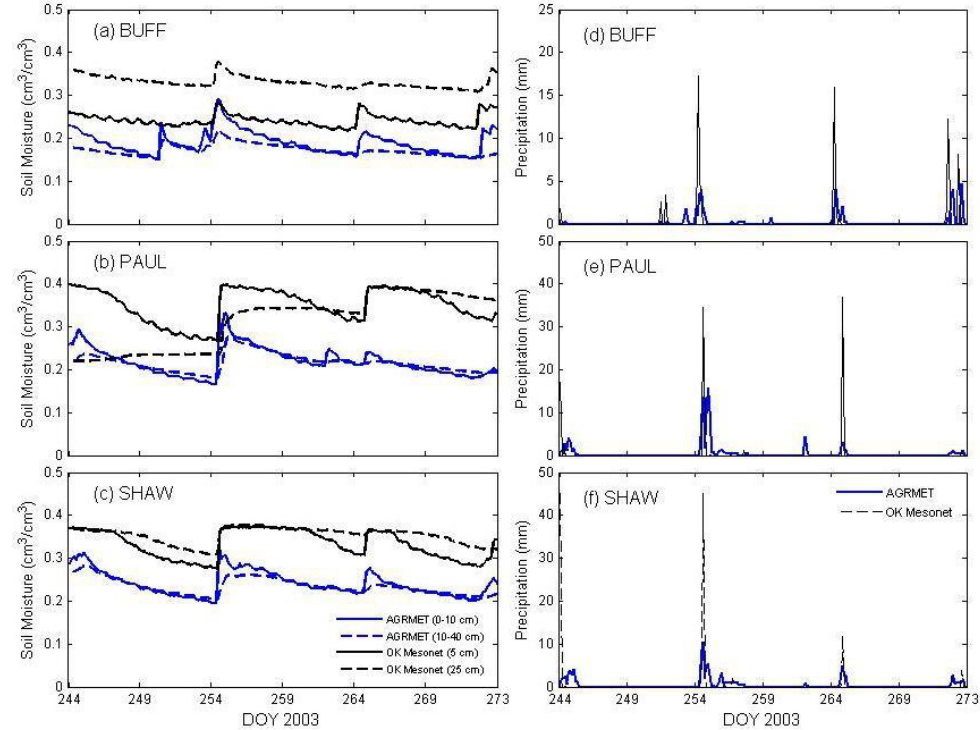
Figure 4. Soil moisture and precipitation comparisons between in situ Oklahoma